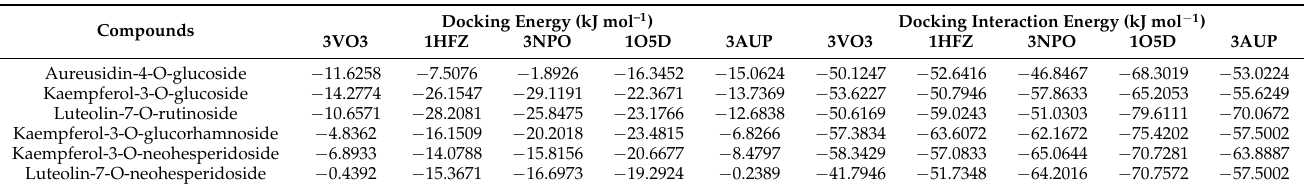
Table 2. Molecular docking energy of six flavonoid monomers and five crystals. The five crystals are BSA (PDB ID: 3VO3), α -La (PDB ID:1HFZ), β -Lg (PDB ID: 3NPO), 11S protein (PDB ID: 1OD5) soybean and 7S protein (PDB ID: 3AUP),